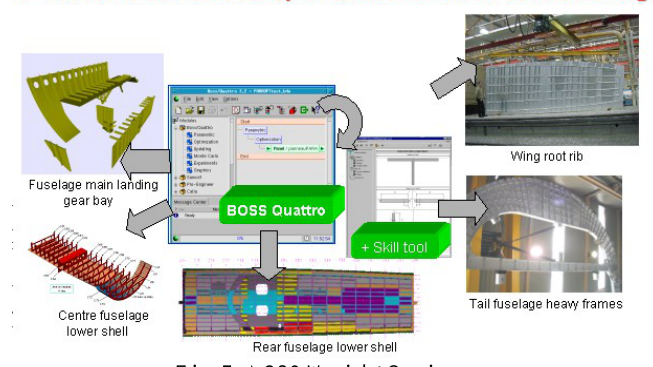
Fig. 5. A380 Weight